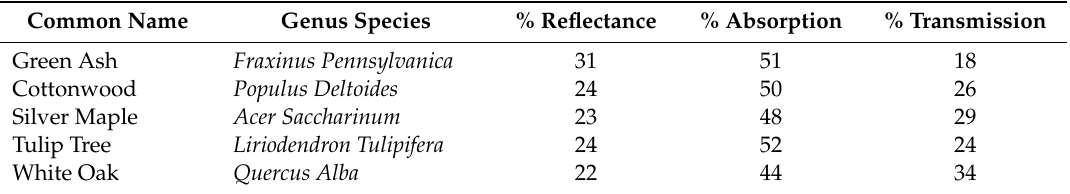
Table 1. Table of typical reflection, absorption, and transmission of shortwave radiation by common street trees in the Chicago region—adapted from [26] (p. 227). * Common Name Genus Species % Reflectance % Absorption % Transmission Green Ash Fraxinus Pennsylvanica 31 51 18 Cottonwood Populus Deltoides 24 50 26 Silver Maple Acer Saccharinum 23 48 29 Tulip Tree Liriodendron Tulipifera 24 52 24 White Oak